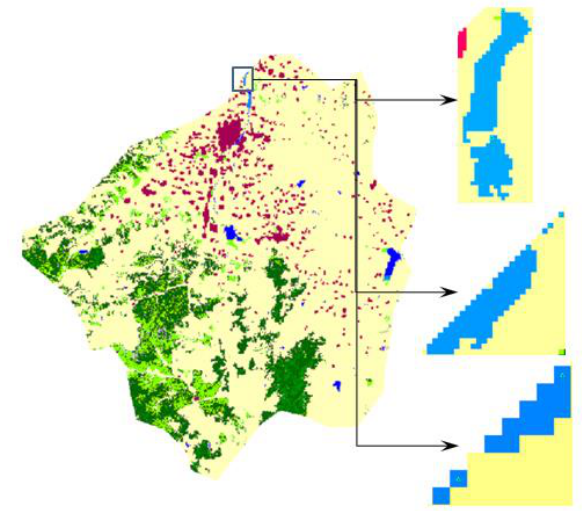
Figure 12. Inconsistency detection for wetland without neighbour of water in study area for year 2000.